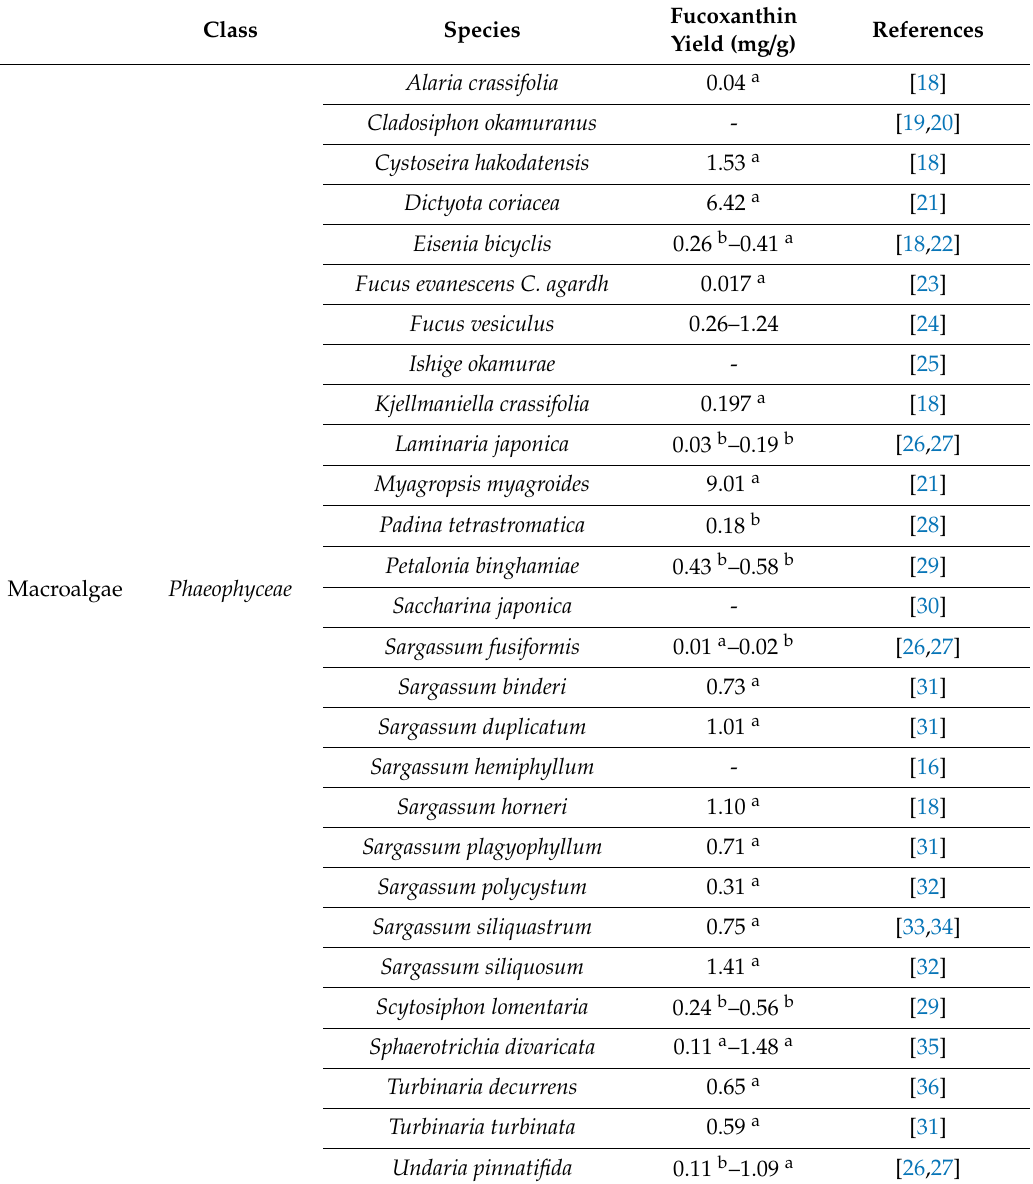
Table 1. Source and concentration of fucoxanthin in di ff erent algal